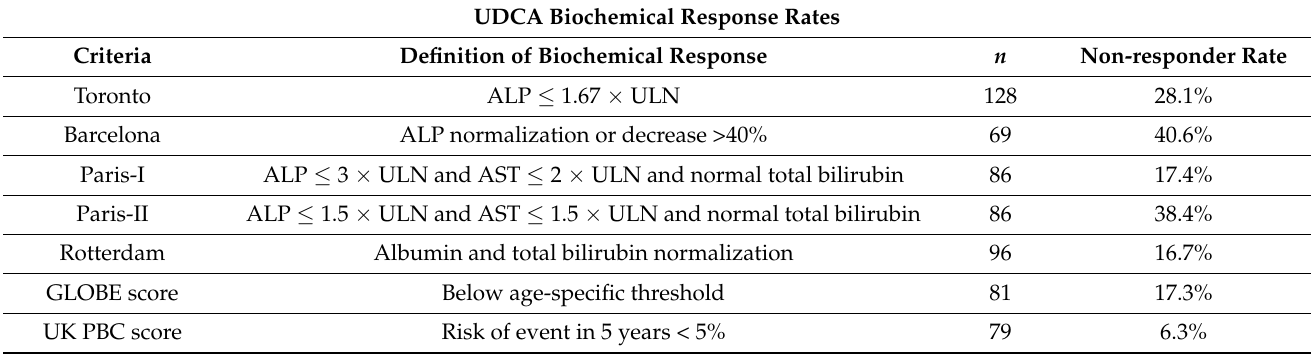
Table 2. UDCA non-response rates according to different criteria. UDCA Biochemical Response Rates